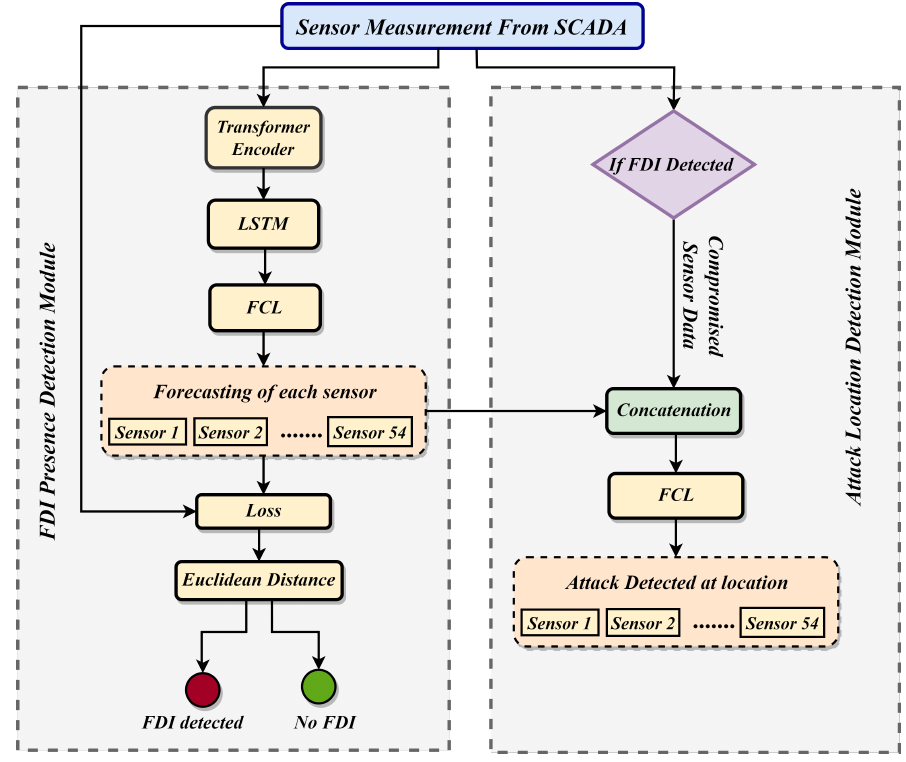
Figure 4. Block diagram of transformer encoder for the proposed